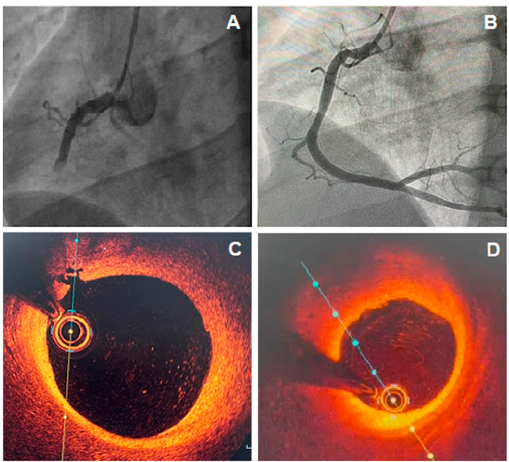
Figure 1. ( A ) Coronary angiography showing total occlusion of the right coronary artery (RCA); ( B ) Coronary angiography of RCA, 5 days after recanalization and intracoronary thrombolytic administration, showing non-obstructive atherosclerotic plaque; ( C , D ) optical coherence tomography (OCT) images showing a lipid plaque with signs of inflammation and intimal rupture.